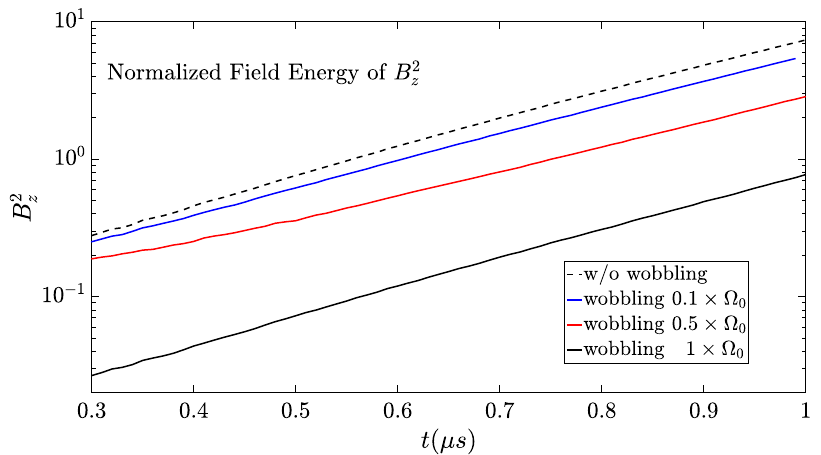
2 Figure 10. Histories of the normalized field energy of B z for the sheet electron current plasma systems with (solid black line) and without (dotted black line) the wobbling or oscillating motion of the sheet electron current along y . The onsets of the filamentation and magnetic reconnection are delayed and mitigated clearly by the dynamic phase control. The solid blue and red curves correspond to the case of wobbling motion with 0.1 (cid:31) 0 and 0.5 (cid:31) 0 ,